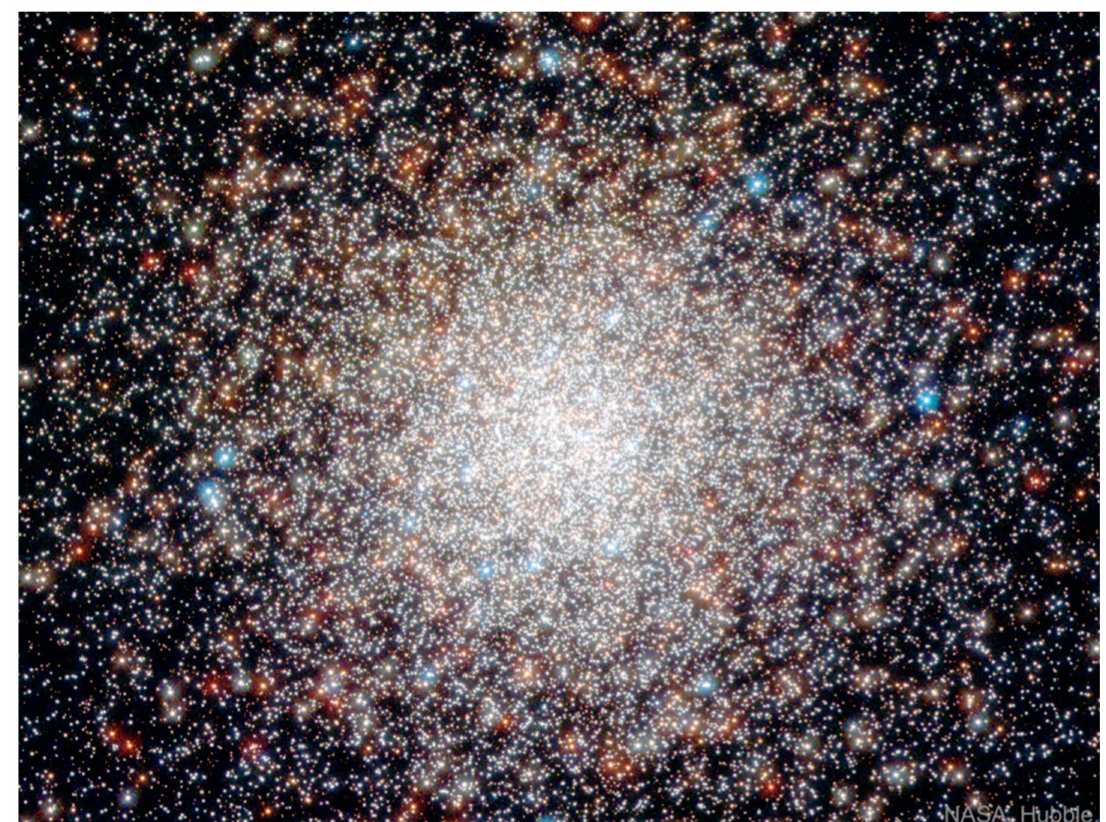
Figure 3. NGC 362, a typical globular cluster. Image credit: NASA/ESA/Hubble WFC3. These correlations apply to all galaxies, but with slight variation depending on